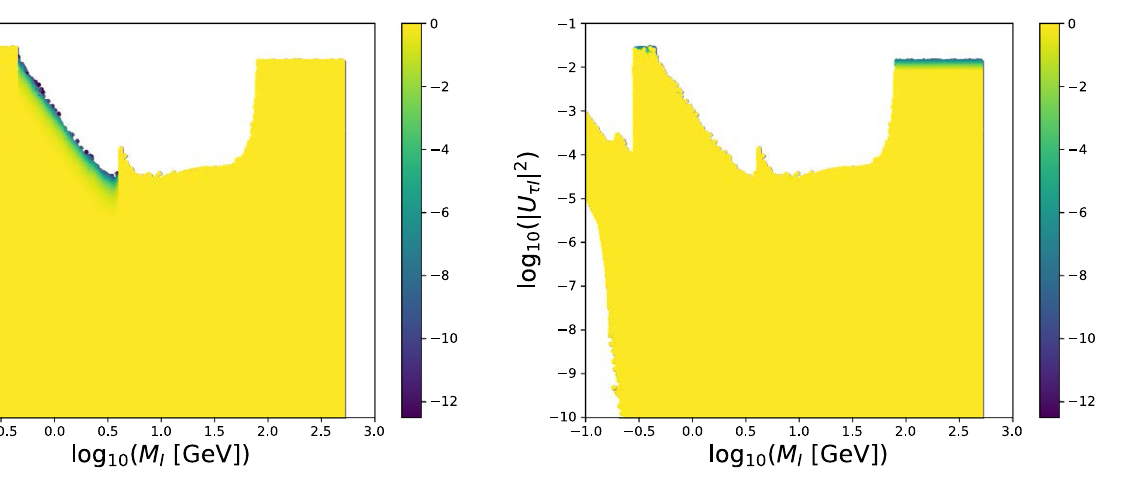
In the mass range M I ∼ ( 0 . 3 , 0 . 5 ) GeV, as well as for large masses M I (cid:2) 80 GeV, direct searches do not con- strain | U τ I | 2 . Hence in these ranges, the strongest constraints come from the invisible decay of the Z boson, as seen in Fig. 40. This figure uses the "capped" likelihood defined pre- viously, so the excesses in Γ inv discussed in Sect. 5 will not be